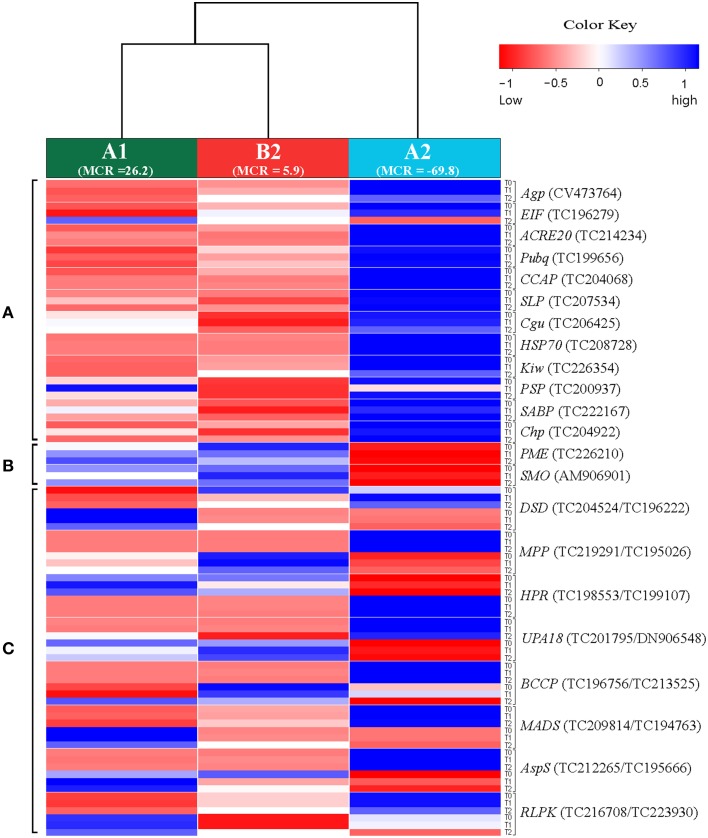
Heatmap showing the expression of 30 unique SuperSAGE tags representing 22 candidate genes (Table 2) in genotype pools A1, B2, and A2. Columns represent the genotype pools A1, B2, and A2 with mean MCR of each pool shown in parenthesis. Rows represent tags per million (tpm) before (T0), one (T1), and two (T2) days after infection. Gene acronyms (see Table 2) are shown to the right with transcript number in parenthesis. The 12 genes at the top (A) were expressed at higher level in the resistant genotype pool A2 compared to both susceptible pools A1 and B2. The two genes in the middle (B) were expressed at higher level in pools A1 and B2 compared to A2. The eight genes at the bottom (C) showed contrasting expression of pairs of allelic tags. Increasing and decreasing expression is indicated by blue and red color, respectively. The numerical data are shown in Supplemental File S4.